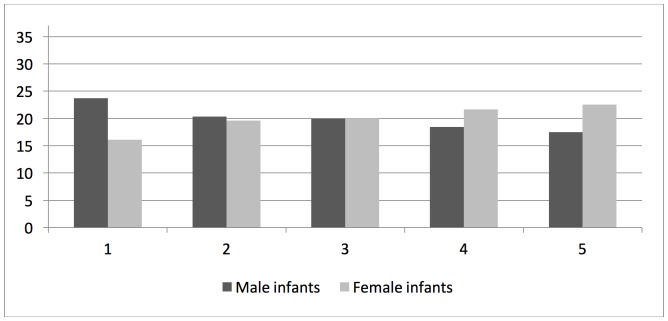
Rates (%) of TREC values in quintiles (1 = lowest quintile) in male and female infants, respectively.(Chi-square p-value<0.001).